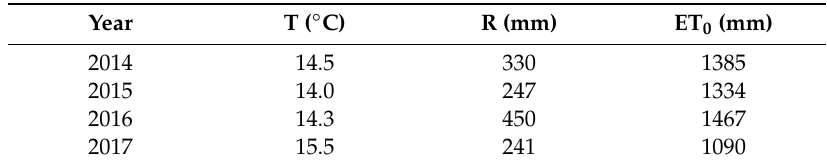
Figure 1. Experimental design. Table 2. Climate data. T: annual temperature; R: accumulated annual rainfall; ET 0 : accumulated annual evapotranspiration.